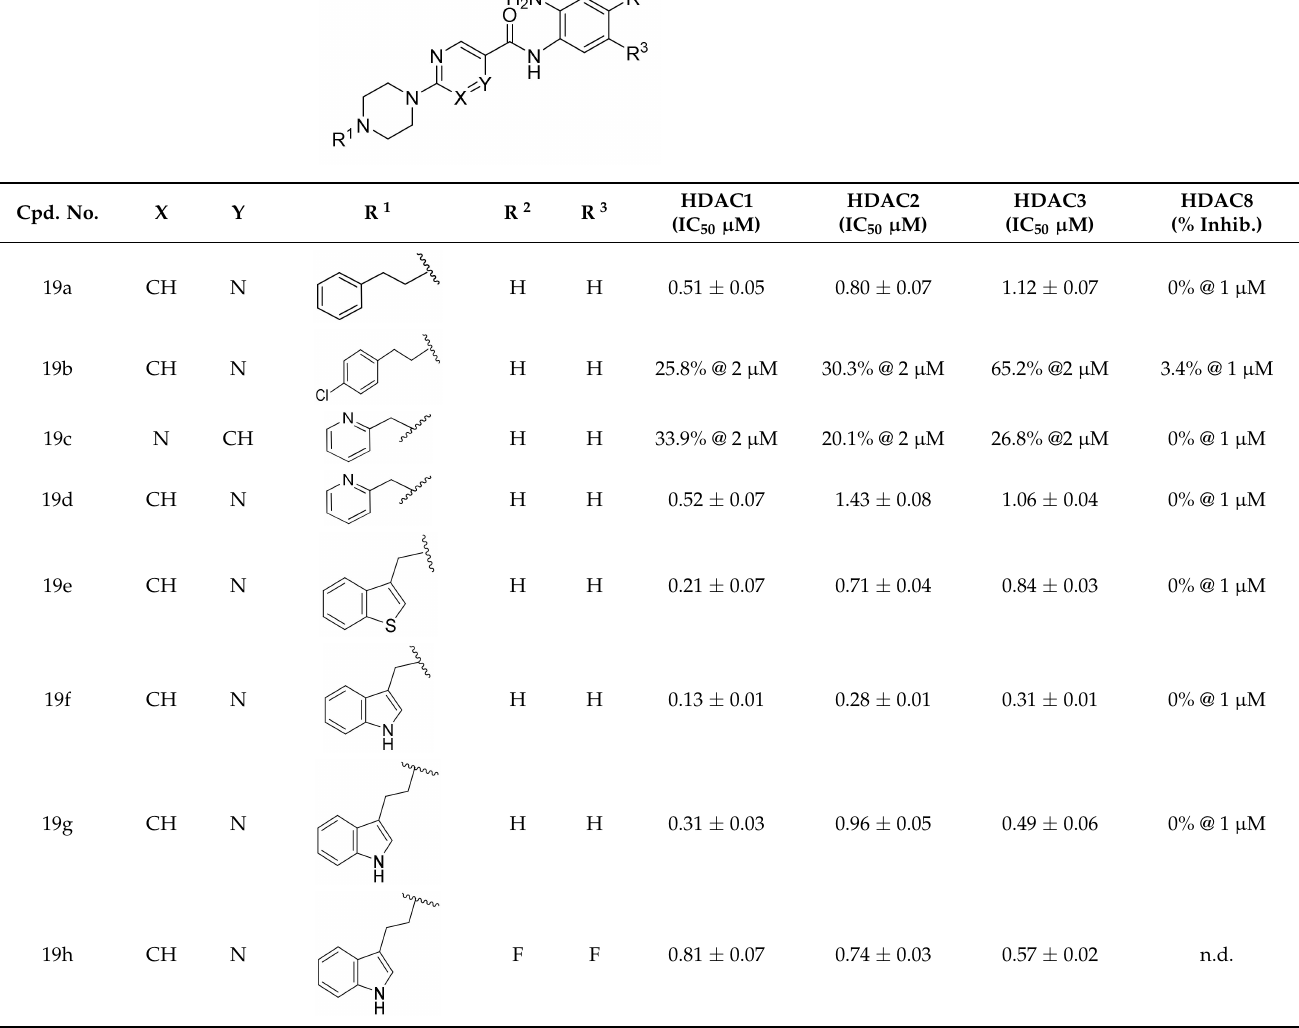
Table 1. Inhibitory activity of the synthesized compounds against class I